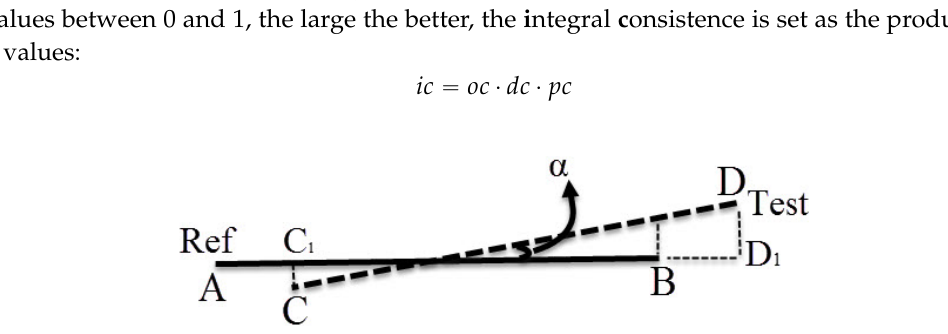
Figure 7. Definition of ridge similarity. Line AB : the reference ridge (Ref); line CD : the detected ridge (Test), where C1 and D1 are the corresponding projection points of C and D; and α is the intersect angle.